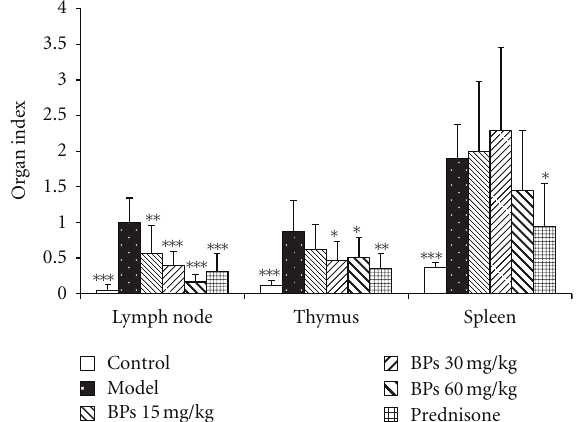
Figure 2: E ff ect of BPs on the index of lymph node, thymus, and spleen in BALB/c and MRL-lpr mice. MRL-lpr mice were grouped randomly and treated with BPs 15, 30, and 60mg · kg − 1 · day − 1 , prednisone 5mg · kg − 1 · day − 1 , or model from week 12 to week 24; data were expressed as means ± SD ( n = 6–8); ∗ P < 0 . 05, ∗∗ P < 0 . 01; ∗∗∗ P < 0 . 001 compared with vehicle treated-model group, tested by ANOVA and Fisher’s